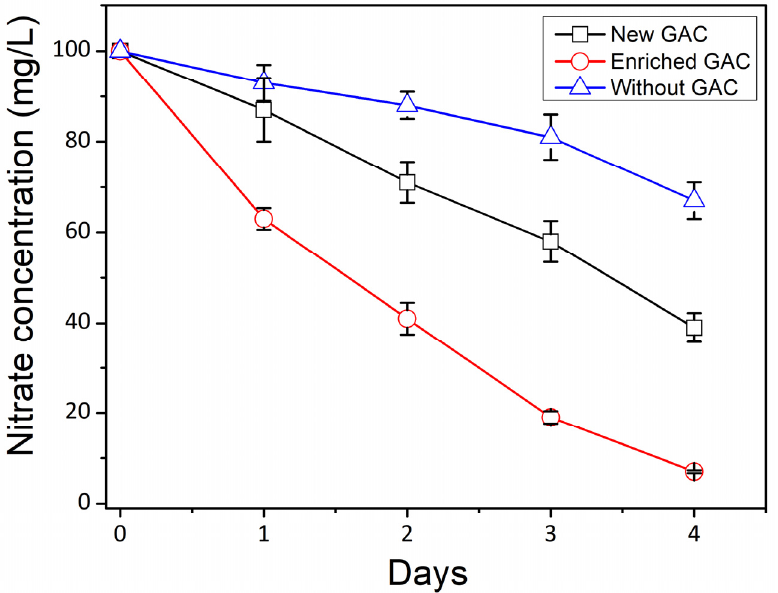
Figure 2. Denitrification observed in the MFC under different cathode conditions. Noticeably, the GAC-biocathode outperformed all the cathode systems tested in this study with the efficiency of reducing over 90% of NO 3 − -N in four days.